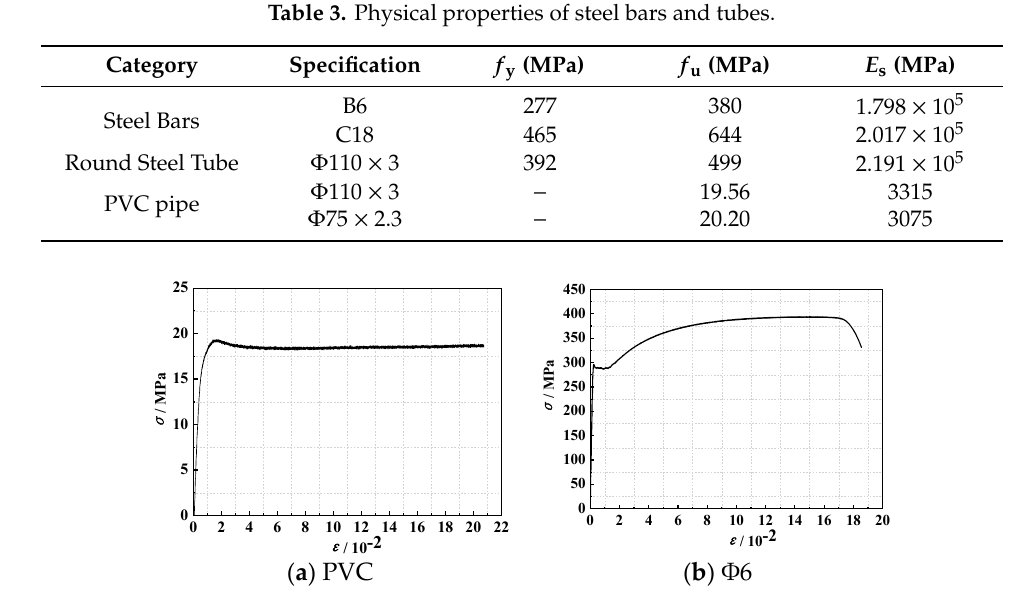
Figure 3. Material stress–strain curves. Table 2. Concrete proportions.